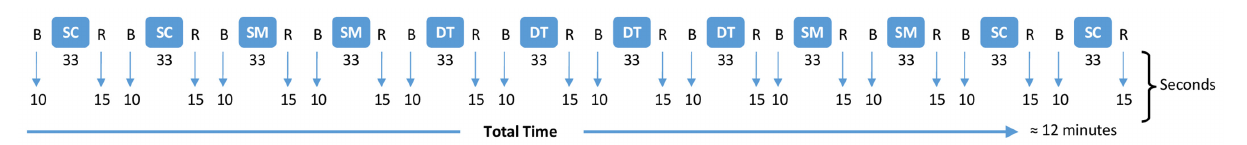
Frontiers in Human Neuroscience |